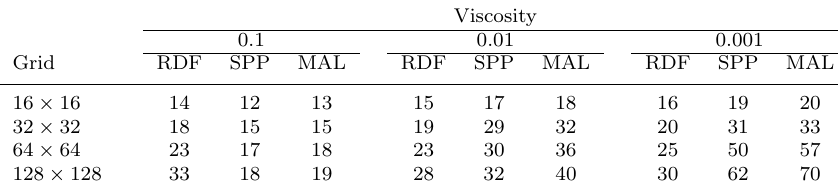
Table 8. Number of GMRES(20) iterations with the RDF, MAL and SPP preconditioners for unsteady Oseen problems (Q2-P1 FEM stretched grids). The parameters τ , α , γ are experimentally